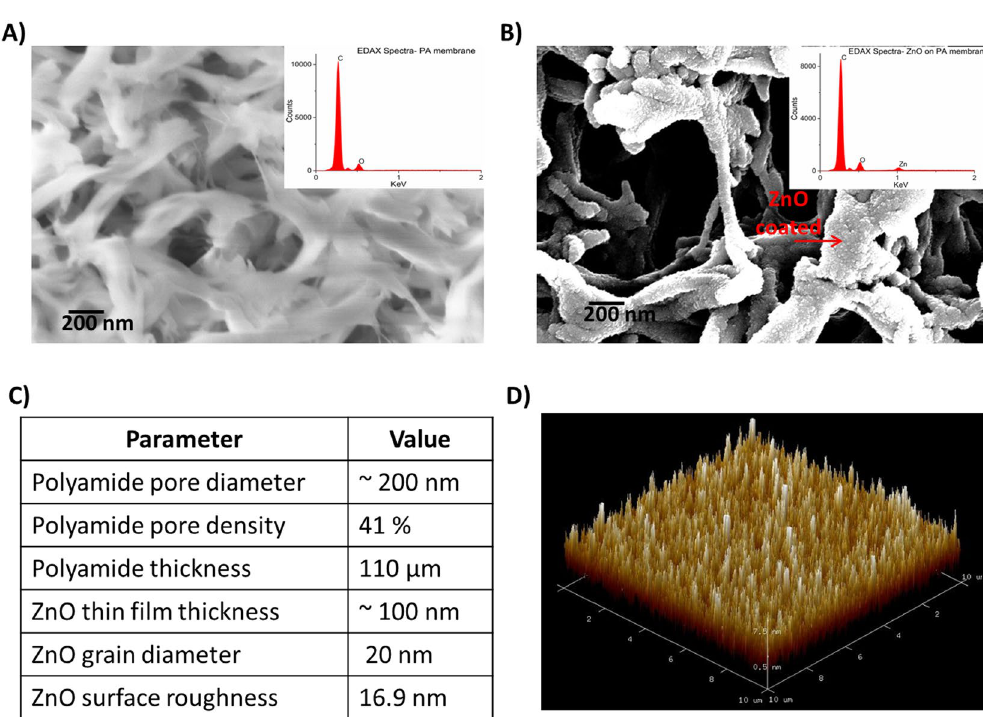
Figure 2. ( A ) SEM of nanoporous flexible membrane with inset showing EDAX spectra of the polyamide membrane surface. ( B ) SEM of ZnO sputtered polyamide membrane with inset showing EDAX spectra of the membrane surface. Zn peaks are only seen on the sputtered polyamide surface. ( C ) Structural parameters of membrane and ZnO thin film D) AFM image of ZnO thin film on silicon